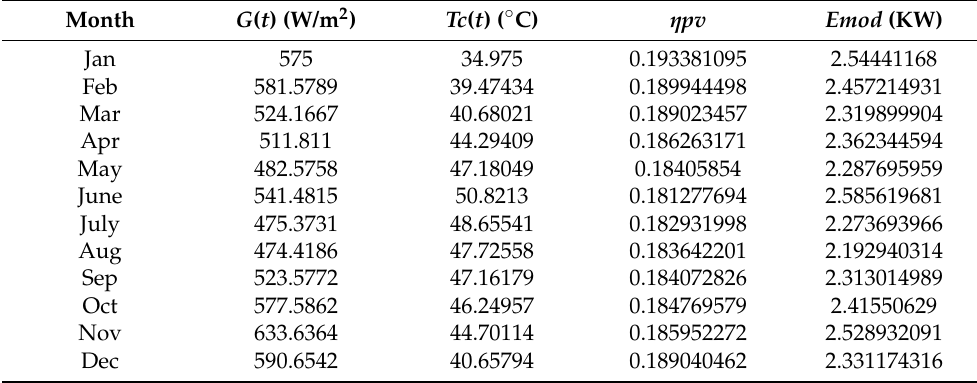
Table 9. Monthly E module and related parameters for